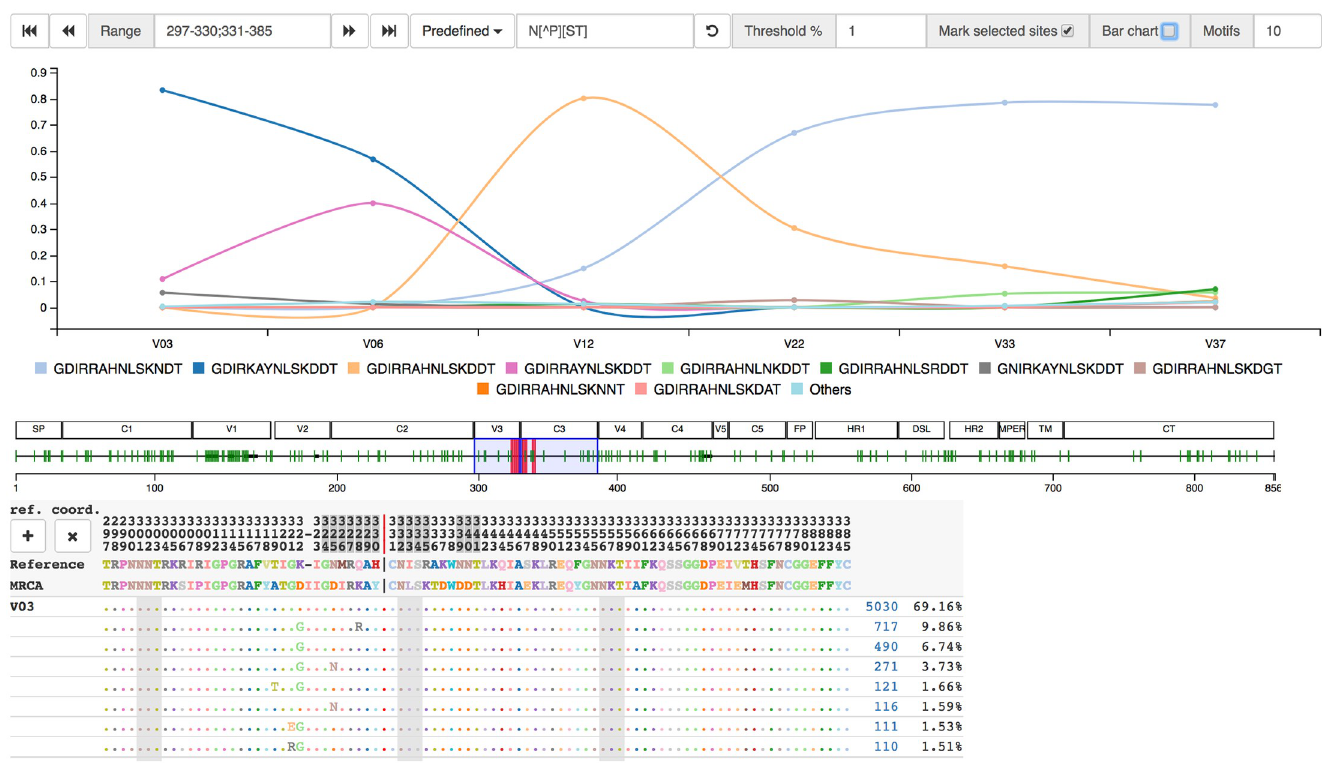
Fig 6. Screenshot of amino acid sequences viewer. Sequences are grouped by identity, with aggregate copy number and population percentage shown to the right. An overview of the amplicon, optionally annotated with region names, provides fast access to different locations of the alignment. Selecting columns of the alignment interactively updates the amino acid dynamics plot, showing the dynamics of the selected motif over time. In this case, the trajectory shows changes in the N332 glycan supersite. Sites inferred by FUBAR to be undergoing positive selection are